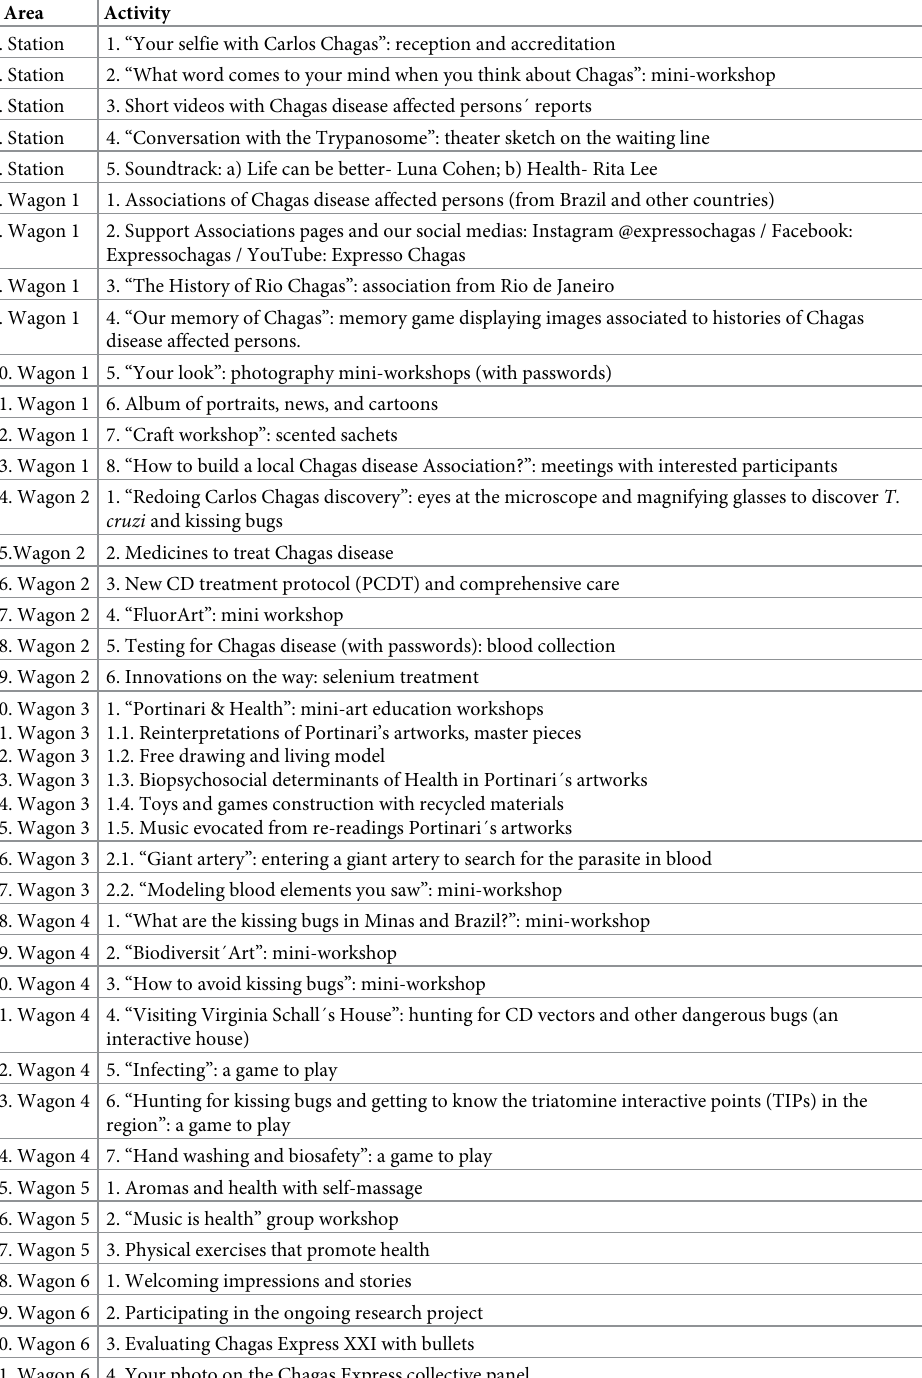
Table 1. Chagas Express XXI ArtScience